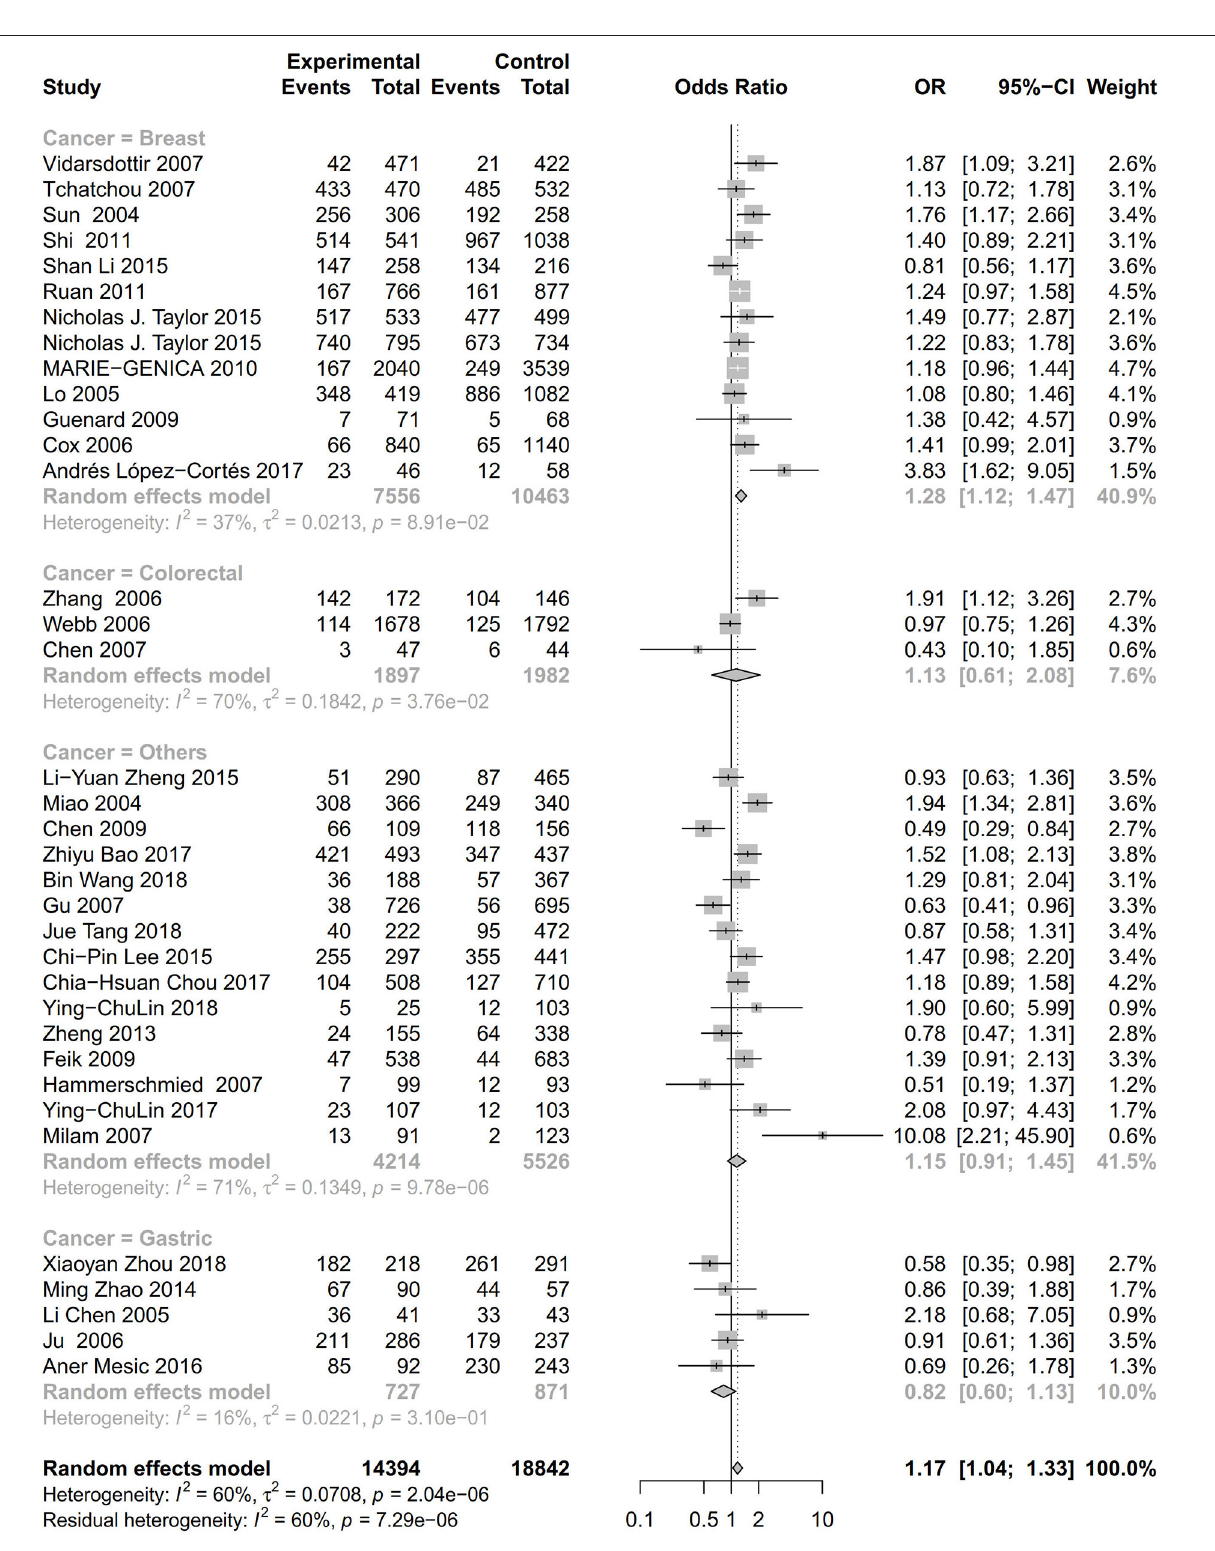
Frontiers in Oncology |